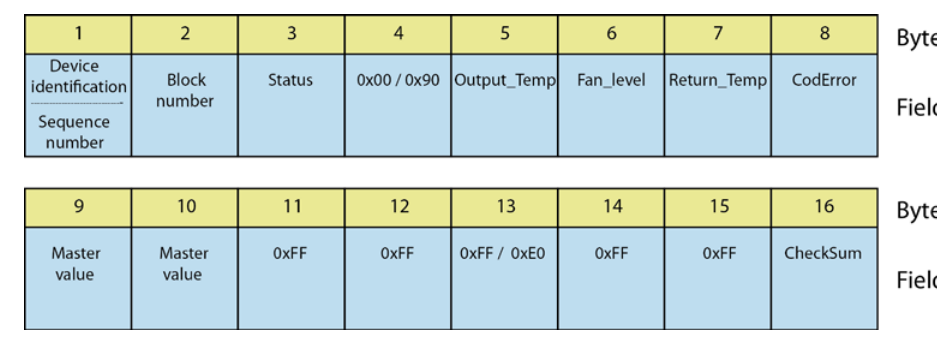
Figure 4. Example of message structure